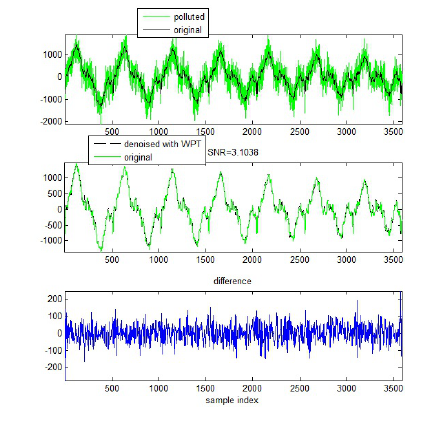
Figure 16. Metrics for WPT-based denoising of signals with descending slope, M = 0.06. Left fig- ures –MAD. Right figures – RMSD. Top – for all elements. Bottom, without 3 elements nearby each edge.